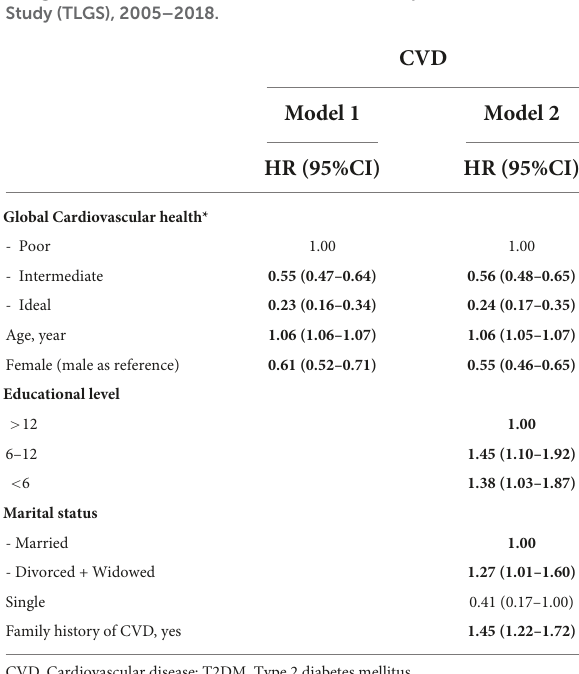
TABLE 4 Multivariable hazard ratios (HRs) and 95% confidence intervals (CI) for the association between global cardiovascular health categories * and cardiovascular disease: Tehran Lipid and Glucose Study (TLGS), 2005–2018.